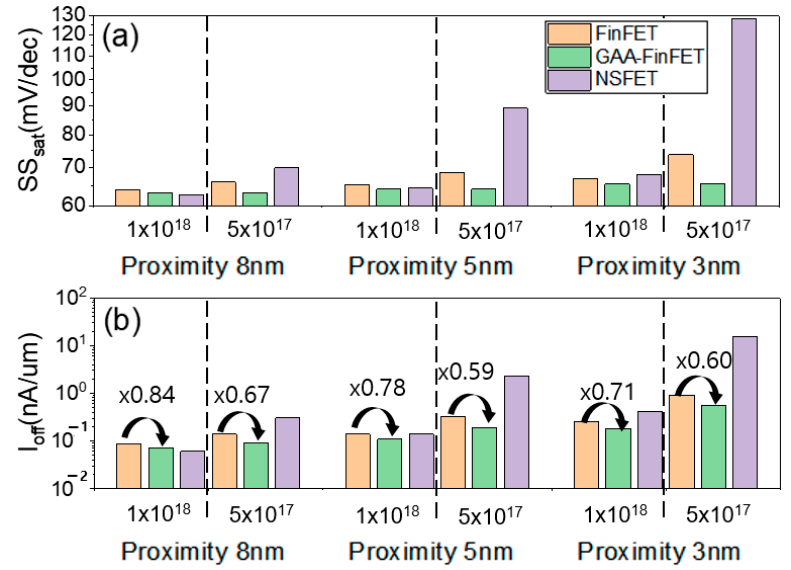
Figure 11. ( a ) SS sat and ( b ) I off for FinFET, GAA-FinFET, and NSFET. Three values of proximity (i.e., 8 nm, 5 nm, and 3 nm) were used for two different doping concentrations in the sub-channel region: 1 × 10 18 cm − 3 and 5 × 10 17 cm − 3 . Figure 12a–c show the input transfer characteristics of three devices with power sup- ply voltage of 0.7 V for the given proximities of 8 nm, 5 nm, and 3 nm, respectively. As in the results obtained with a doping concentration of 1 × 10 18 cm − 3 , the off-state leakage cur- rent (I d at V GS of 0 V) of GAA-FinFET exhibited a smaller decrease than that obtained for FinFET and NSFET with increasing proximity.